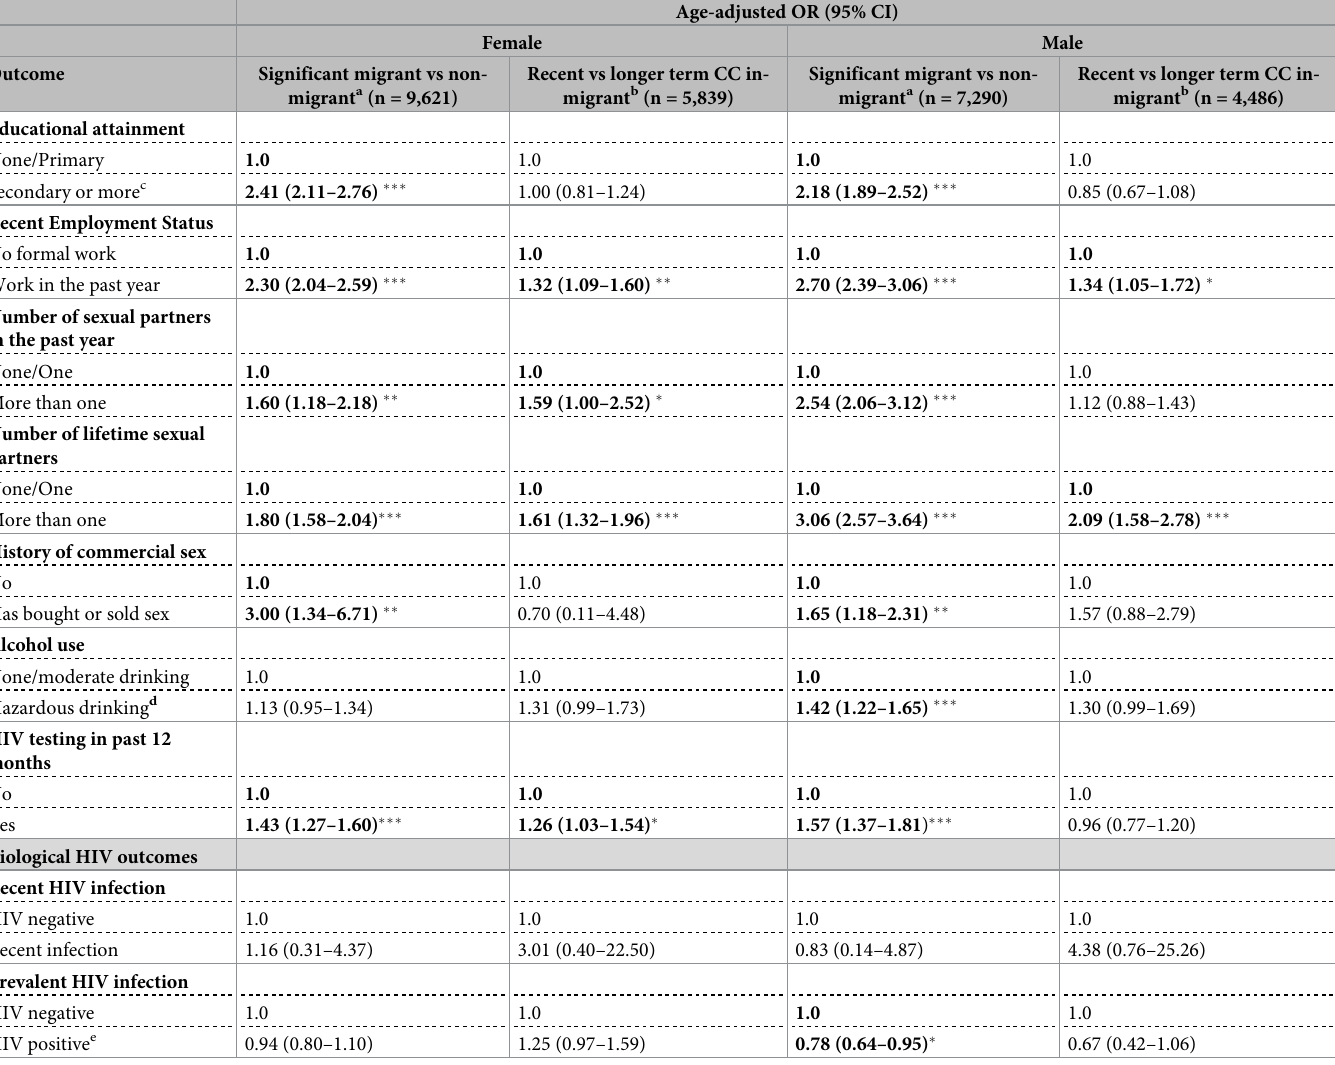
Table 2. Associations between the two indices of migration and HIV risk behaviors by sex among participants in the 2017 Namibia Population-based HIV Impact Assessment